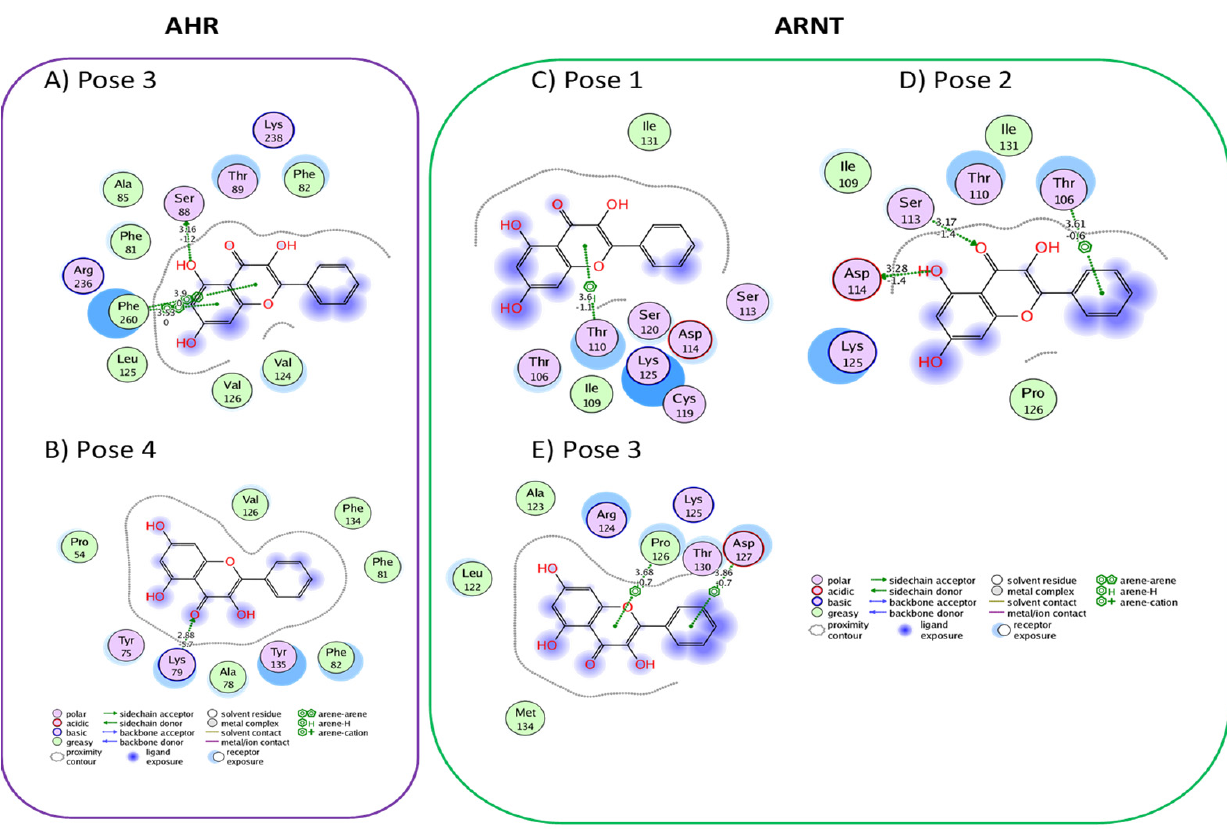
Figure 11. Interaction network between monomeric protein AHR, ARNT and the studied compound 6 .